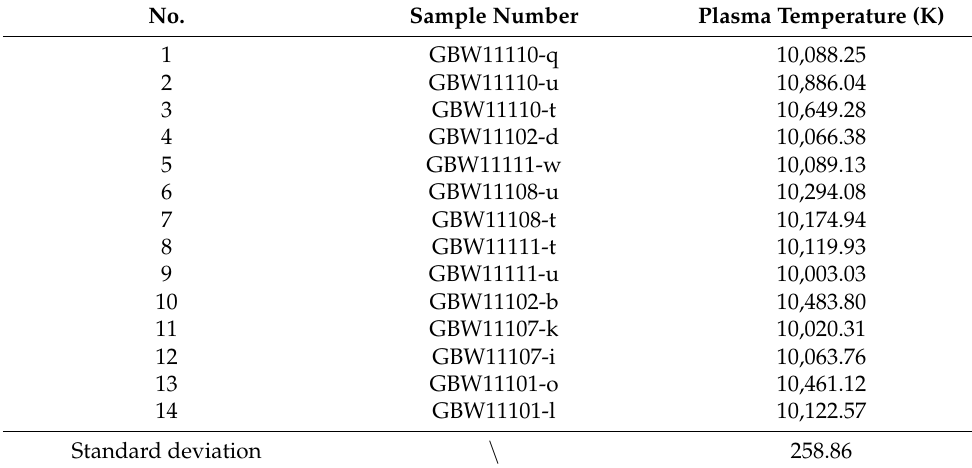
Table 3. The plasma temperatures of the fourteen standard pulverized coals.